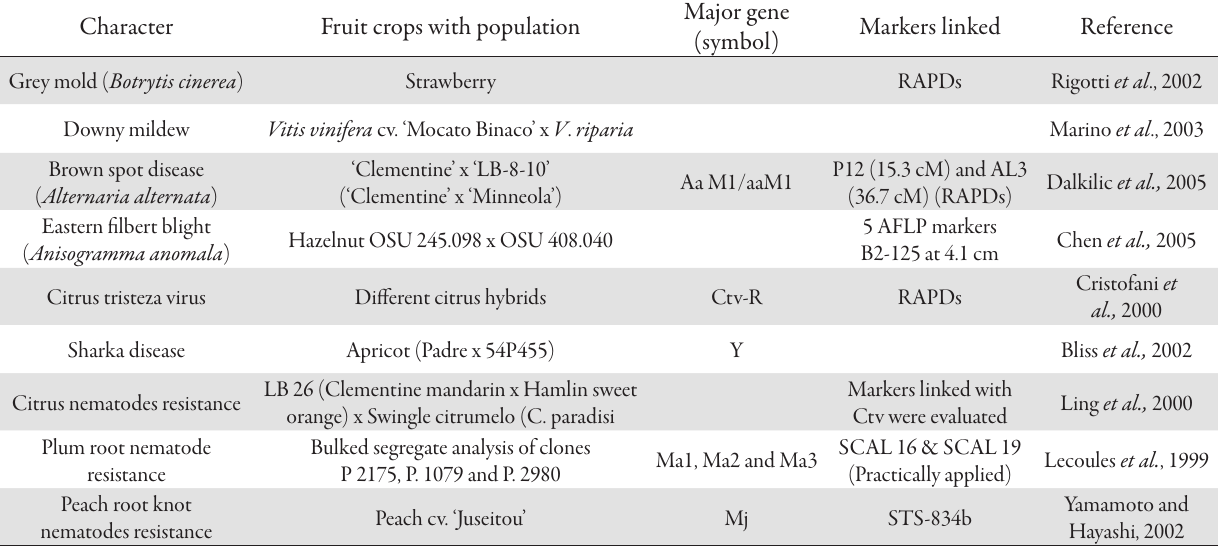
Tab. 8. DNA Markers for disease